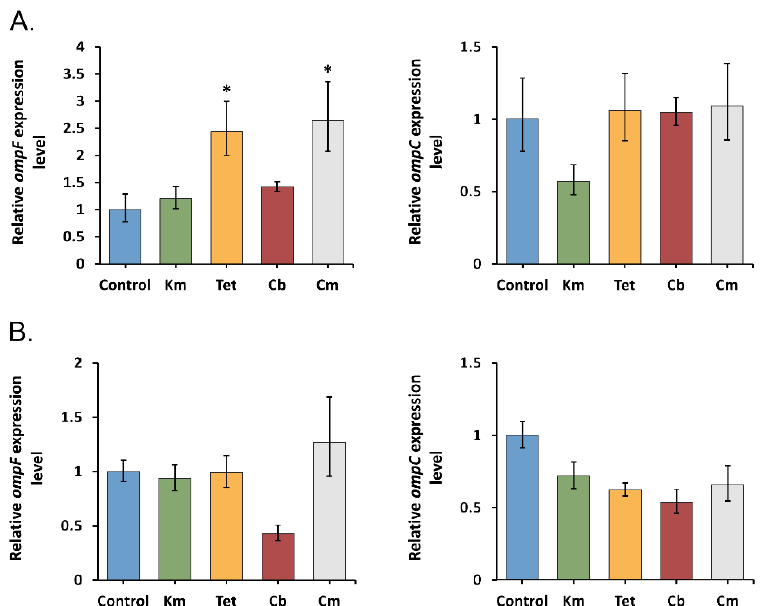
Figure 2. Relative expression levels of Y. pseudotuberculosis ompF and ompC after prolonged antibiotic exposure detected by qRT-PCR. ( A ) 27 ◦ C incubation temperature; ( B ) 37 ◦ C incubation temperature. All results are expressed as mean ± standard deviation from three independent experiments. An asterisk indicates p -value < 0.05 vs. respective untreated control. Significance was calculated using one-way ANOVA. Km — kanamycin, Tet — tetracycline, Cb — carbenicillin, and Cm — chloramphenicol.